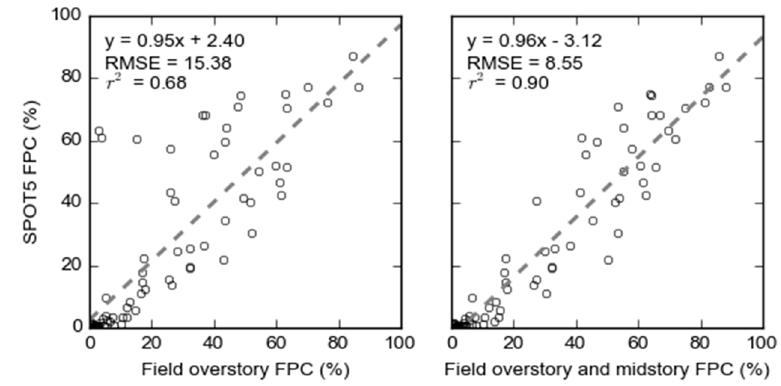
Figure 5. A comparison of the modelled foliage projective cover (FPC) derived from the time-series of SPOT5 imagery to field measured FPC at 76 sites across New South Wales, Australia. The dashed lines and equations represent the line of best fit derived from ordinary least squares regression, which confirmed that the SPOT5 FPC had a stronger relationship (lower RMSE and higher r 2 ) to field data when the midstorey component was included.